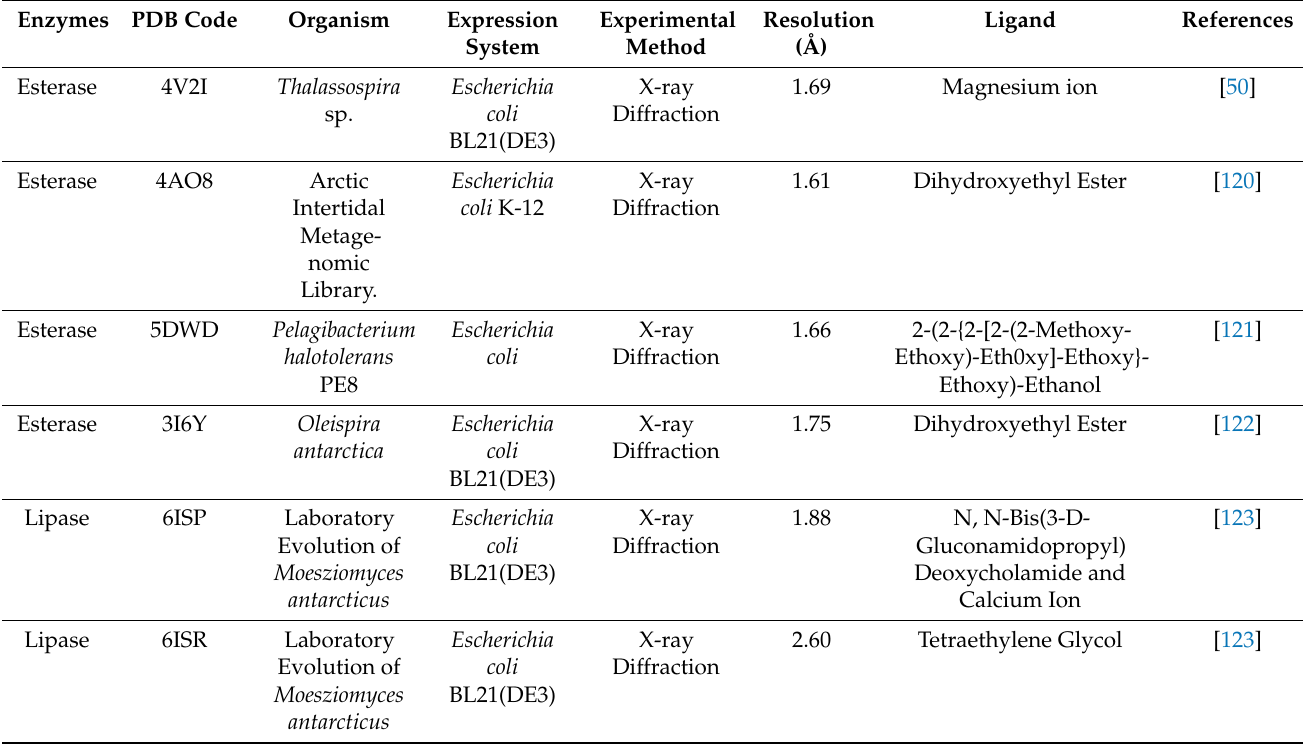
Table 3. Summary of resolved crystal structures of cold-active lipases and